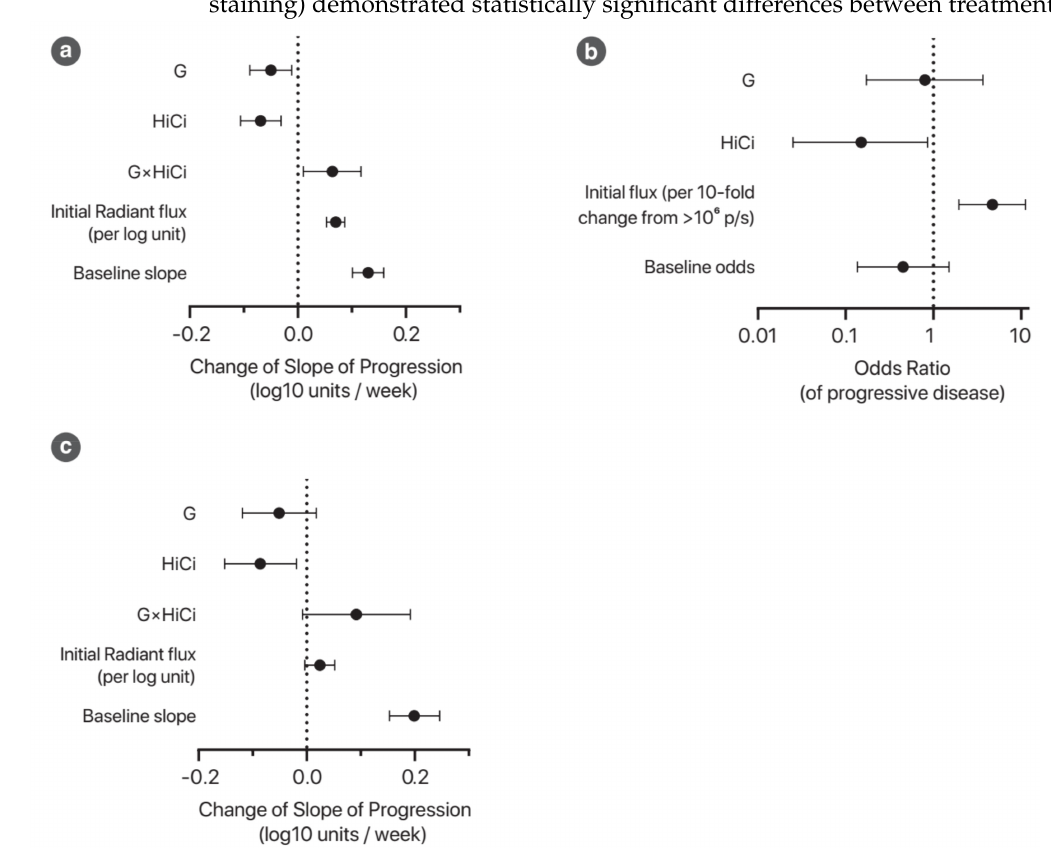
Figure 1. Progression of disease with adjuvant treatment ( n = 62). ( a ) Graphical representation of the mixed-effects model for longitudinal analysis of tumour burden. This plot illustrates the coefficients for the interaction terms with treatment weeks; thus, these represent factors that change the slope of the disease burden curve. The units for these coefficients are log10 n-fold change of radiant flux per week. The baseline condition represents mice with an initial flux of 10 6 p/s (photons/second) in the control group, although the baseline for a given animal is assumed to vary (random intercepts model). The full model specification can be found in Table A2. ( b ) Logistic regression model predicting probability of progressive disease. Progressive disease was defined by a statistically and clinically significant increase in the disease burden (see definition in the methods in the Appendix A). The odds ratio represents the change in the odds of progressive disease when the relevant variable is true (compared to the baseline case). The intercept for this model represents the baseline odds of progressive disease. See Table A3 for full model specification. ( c ) This subgroup analysis focusses on mice with recurrent disease. Refer to Table A4 for full model